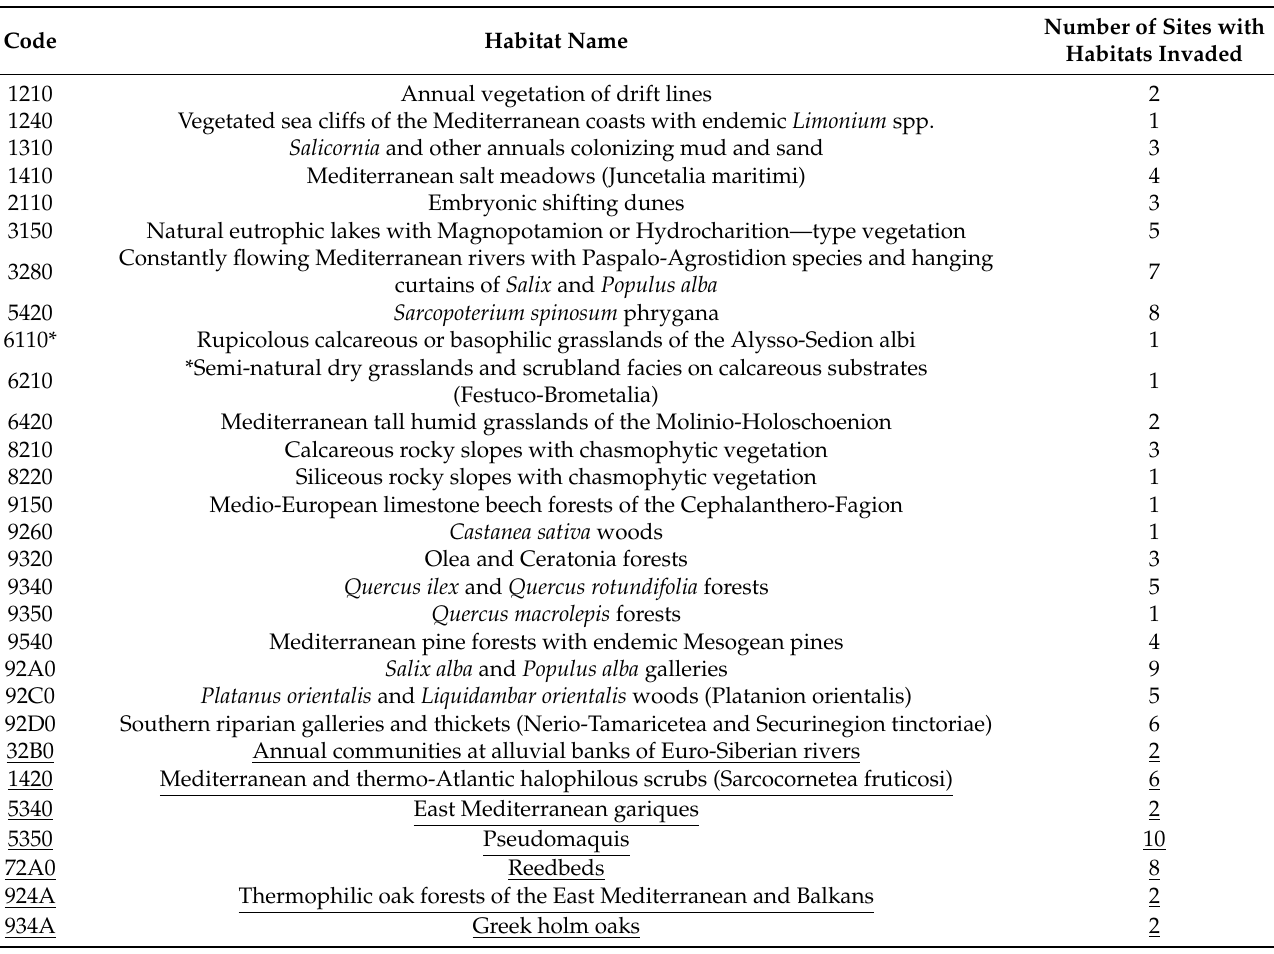
Table 2. Habitat types invaded by Solanum elaeagnifolium in Greek Natura 2000 sites, and number of sites where these invaded habitats were found. Asterisk (*) in habitat code denotes priority habitat according to the EU Directive 92/43/EEC. Habitat types important for Greece and not indexed in Annex I of the EU Directive 92/43/EEC are underlined.